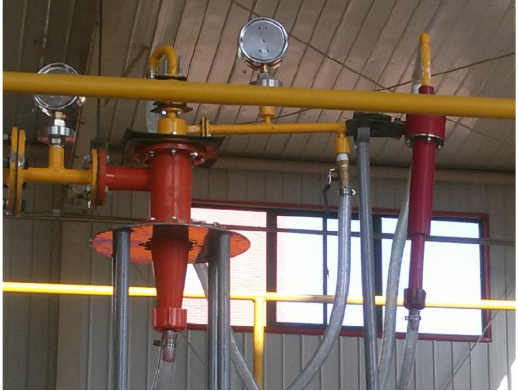
Figure 4. Schematic of the experimental site.